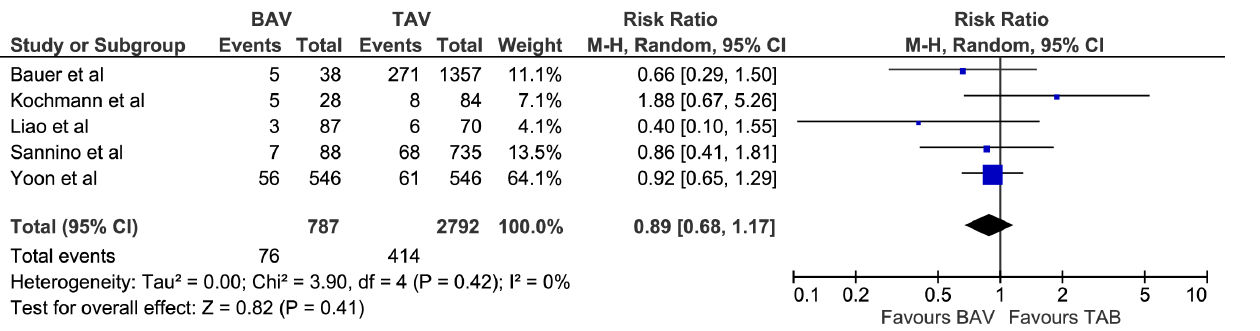
Fig. 6 - Forest plot for postoperative 1-year mortality. BAV=bicuspid aortic valve; CI=confidence interval; M-H=Mantel-Haenszel; TAV=tricuspid aortic